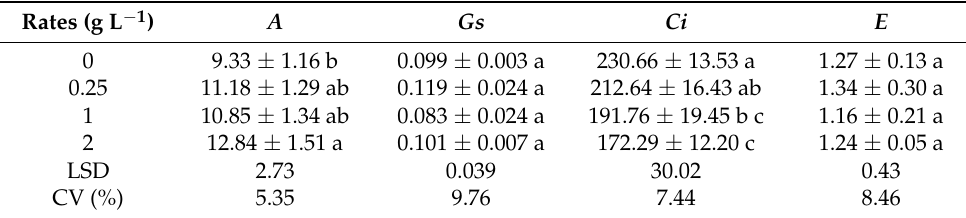
Table 1. Net assimilation rate ( A , µ mol CO 2 m − 2 s − 1 ), stomatal conductance ( Gs , mol m − 2 s − 1 ), inter- nal CO 2 leaf concentration ( Ci , µ mol CO 2 mol − 1 air) and transpiration rate ( E , mmol H 2 O m − 2 s − 1 ),